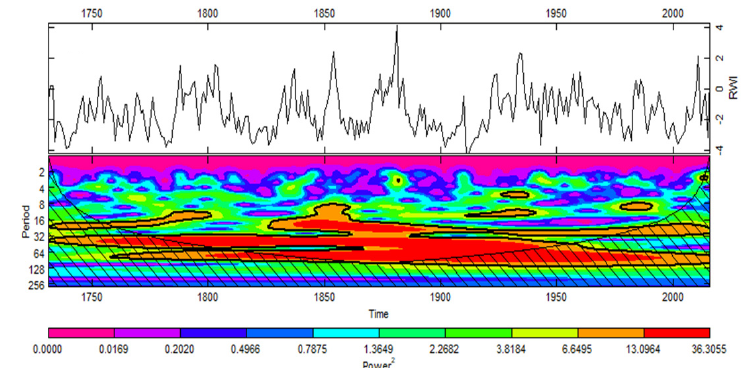
Figure 8. Wavelet plots for reconstructed June PDSI. Areas surrounded by thick black contours (95% significant level, using red noise background spectrum) are regions of significant power at corresponding timescales.